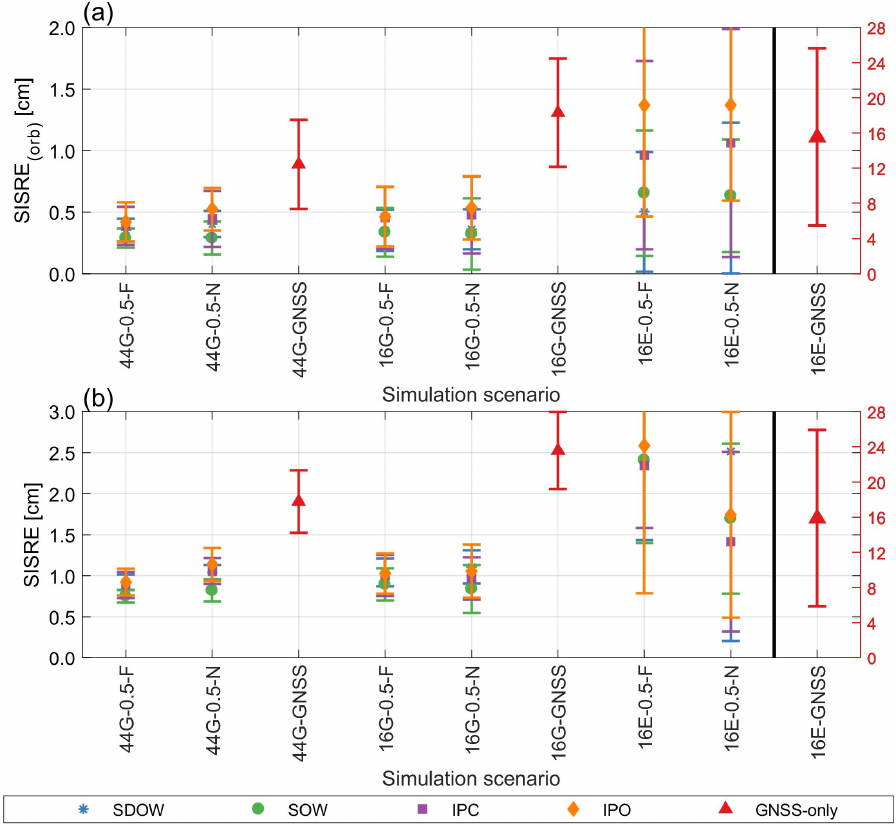
Figure 9. ( a ) SISRE (orb) and ( b ) SISRE values computed under different simulation scenarios. Please note that values for 16E-GNSS are presented with different vertical axis in cm.